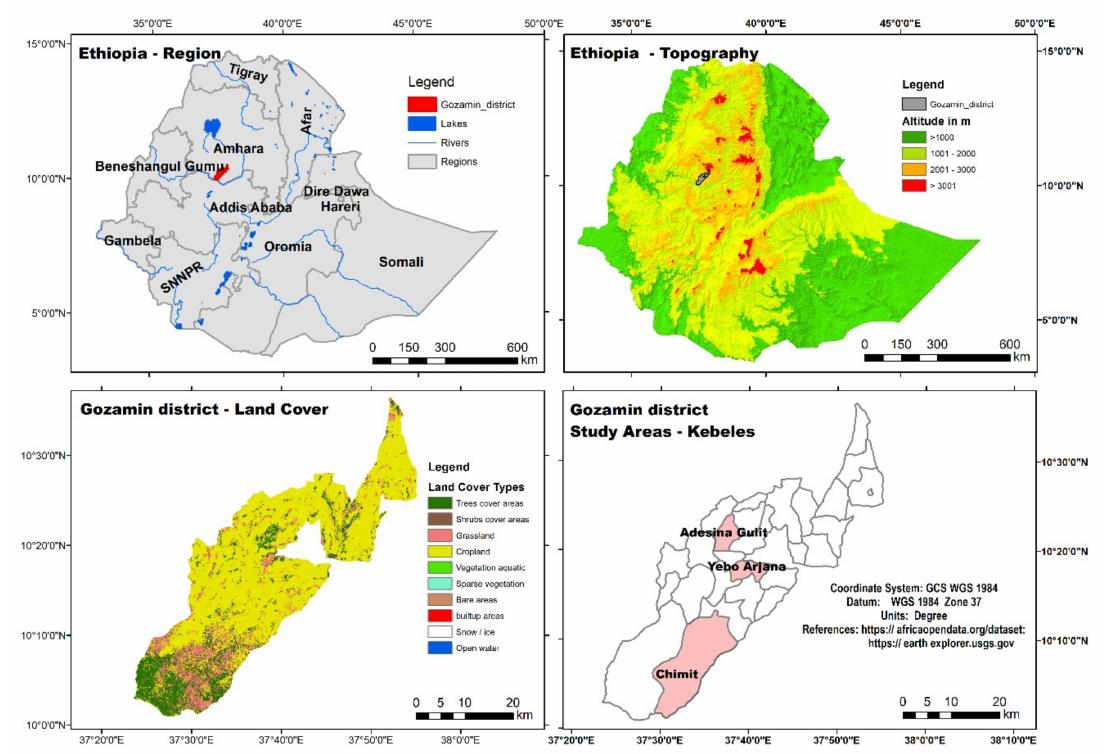
Figure 1. The study area—Gozamin